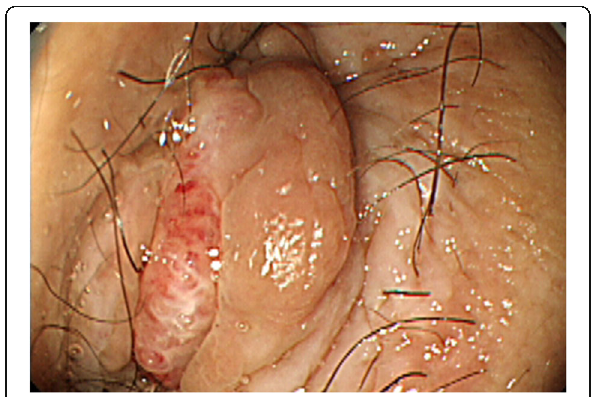
Fig. 3 The anal tumor stained with hematoxylin and eosin. Moderately differentiated adenocarcinoma was observed from the squamous epithelium to the submucosal